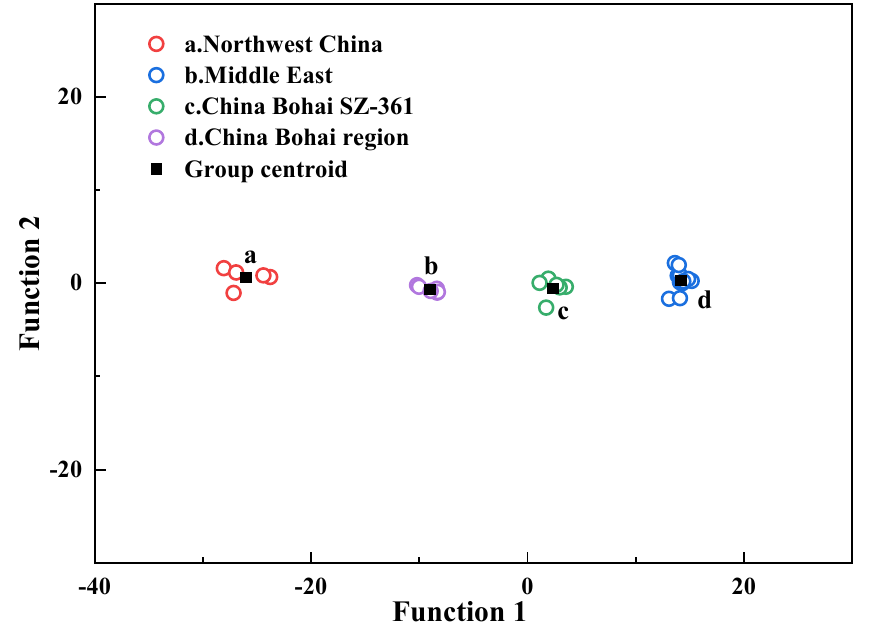
Figure 11. Discriminant function scatter plot. Table 4. Original and cross verification of Fisher’s discrimination